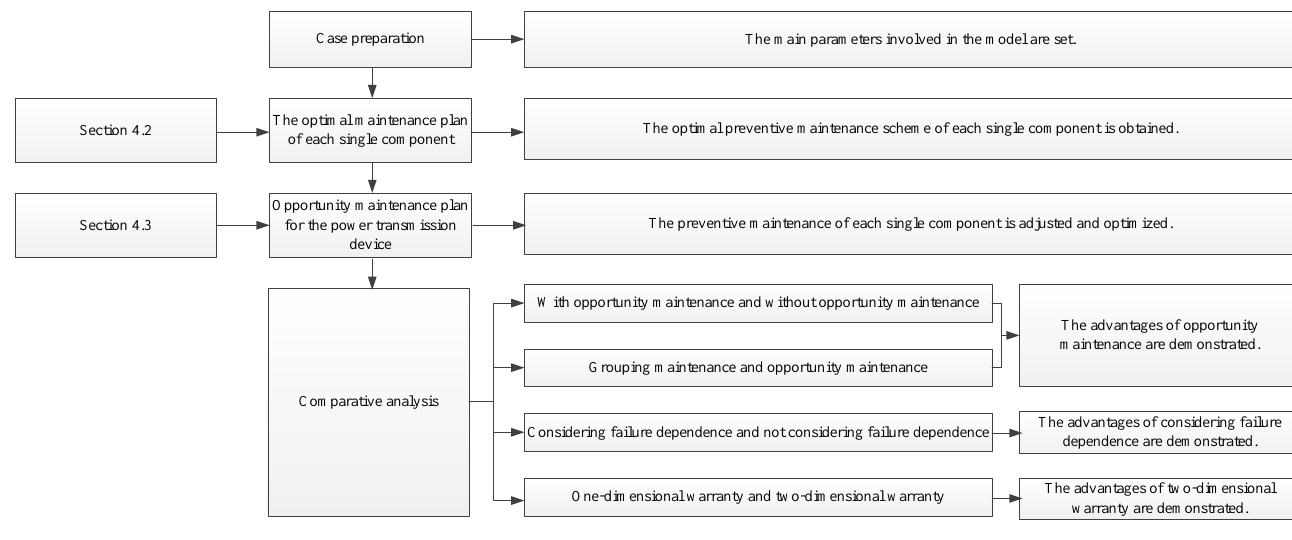
Figure 8. The logic of the case.